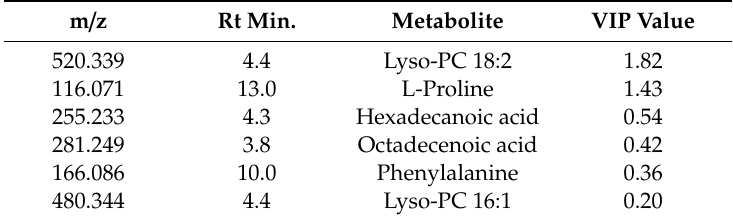
Table 2. The six metabolites used to produce the OPLS model shown in Figure 1 m / z Rt